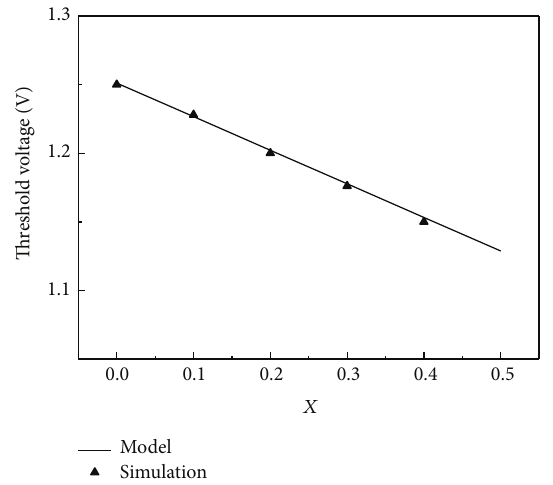
Figure 8: Threshold voltage versus strained Si layer thickness 𝑡 SSi . 𝜀